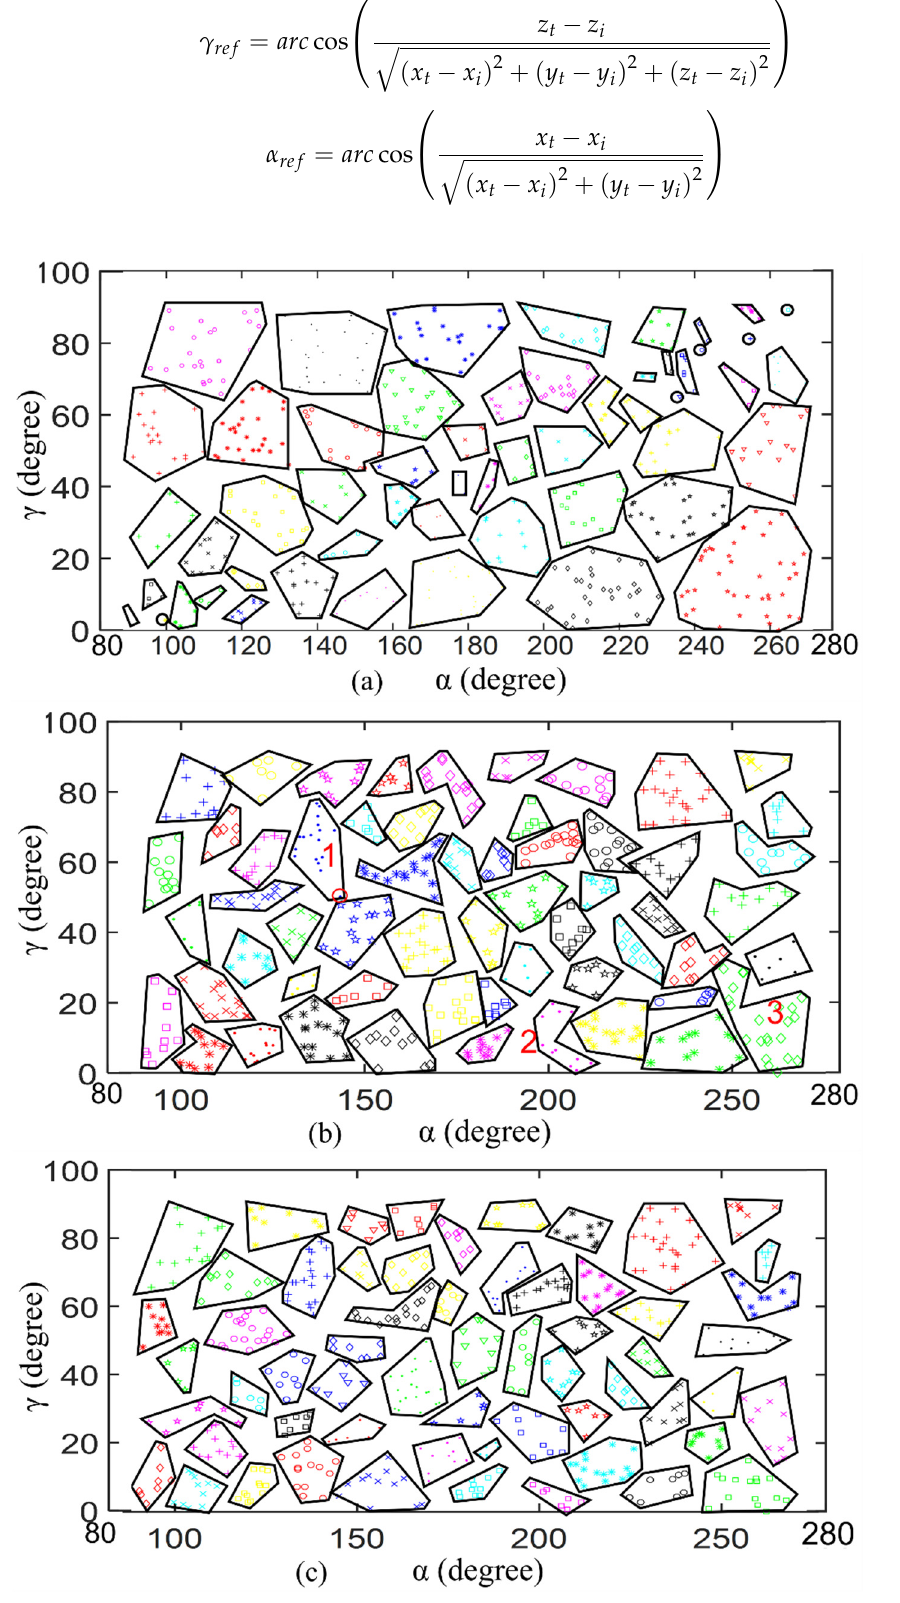
Figure 9. Clustering results of training data: ( a ) clustered by K-means;.( b ) clustered by DBSCAN; ( c ) clustered by MNNC.